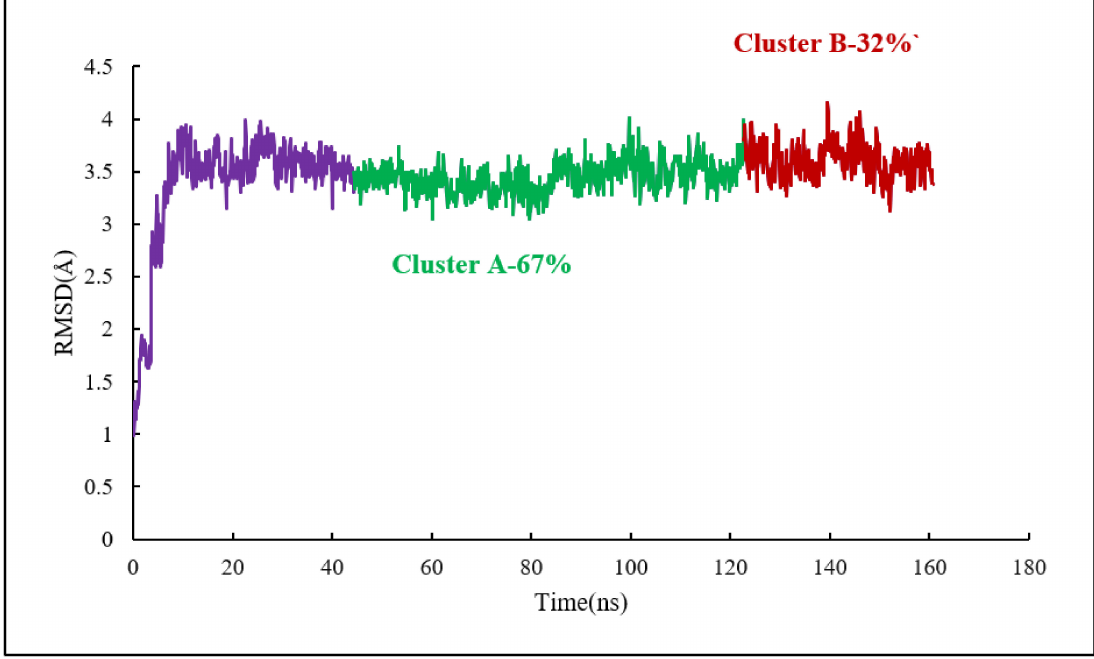
Figure 15. Mass-weighted root–mean–squared deviation (Å) of the binding sites of laulimalide to tubulin, classified according to cluster number, with their occupancy indicated. The binding site includes scoulerine and tubulin residues whose atoms are within 8 Å of scoulerine. The purple part of the graph illustrates the equilibration phase of the